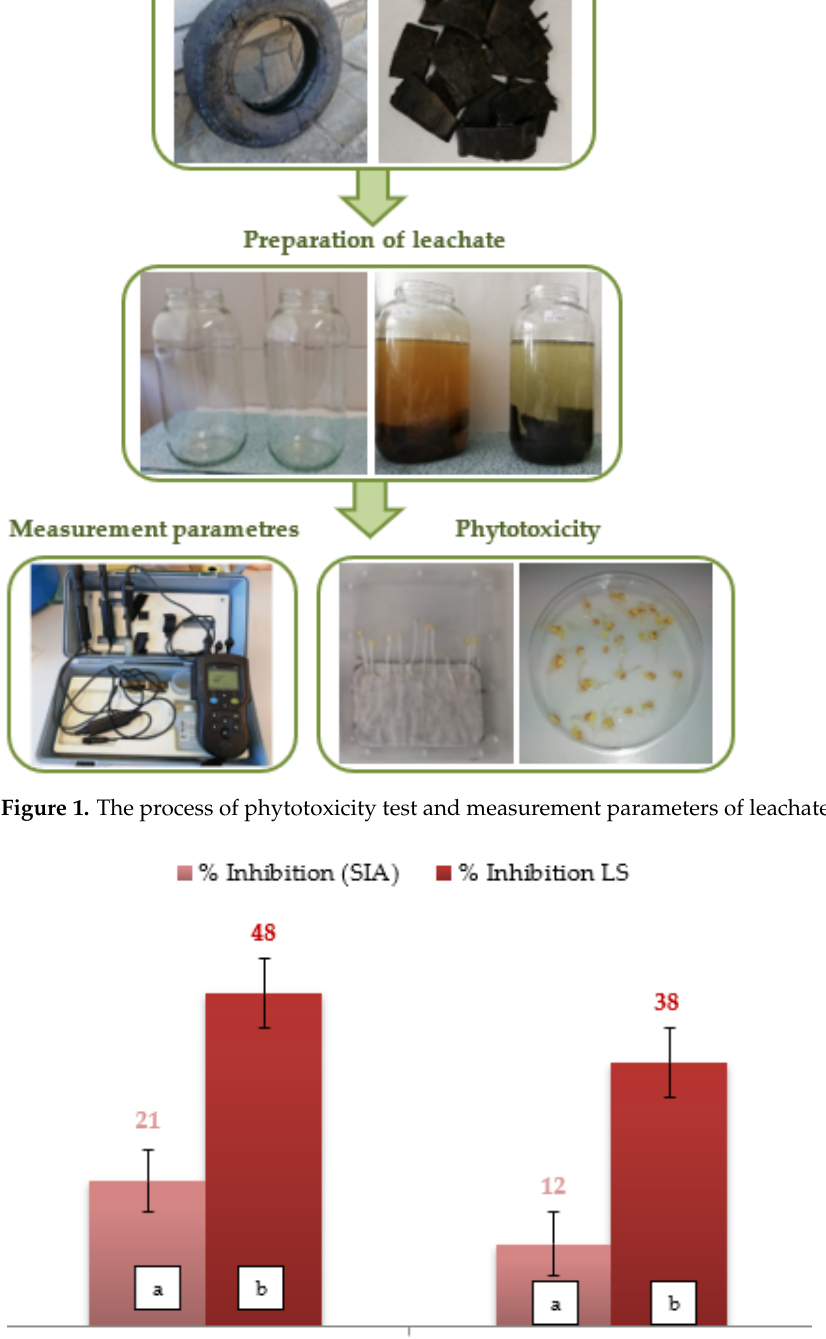
Figure 2. Inhibition of root growth (IR) in Sinapis alba L. (SIA) and Lepidium sativum L. (LS) in the test of phytotoxicity.